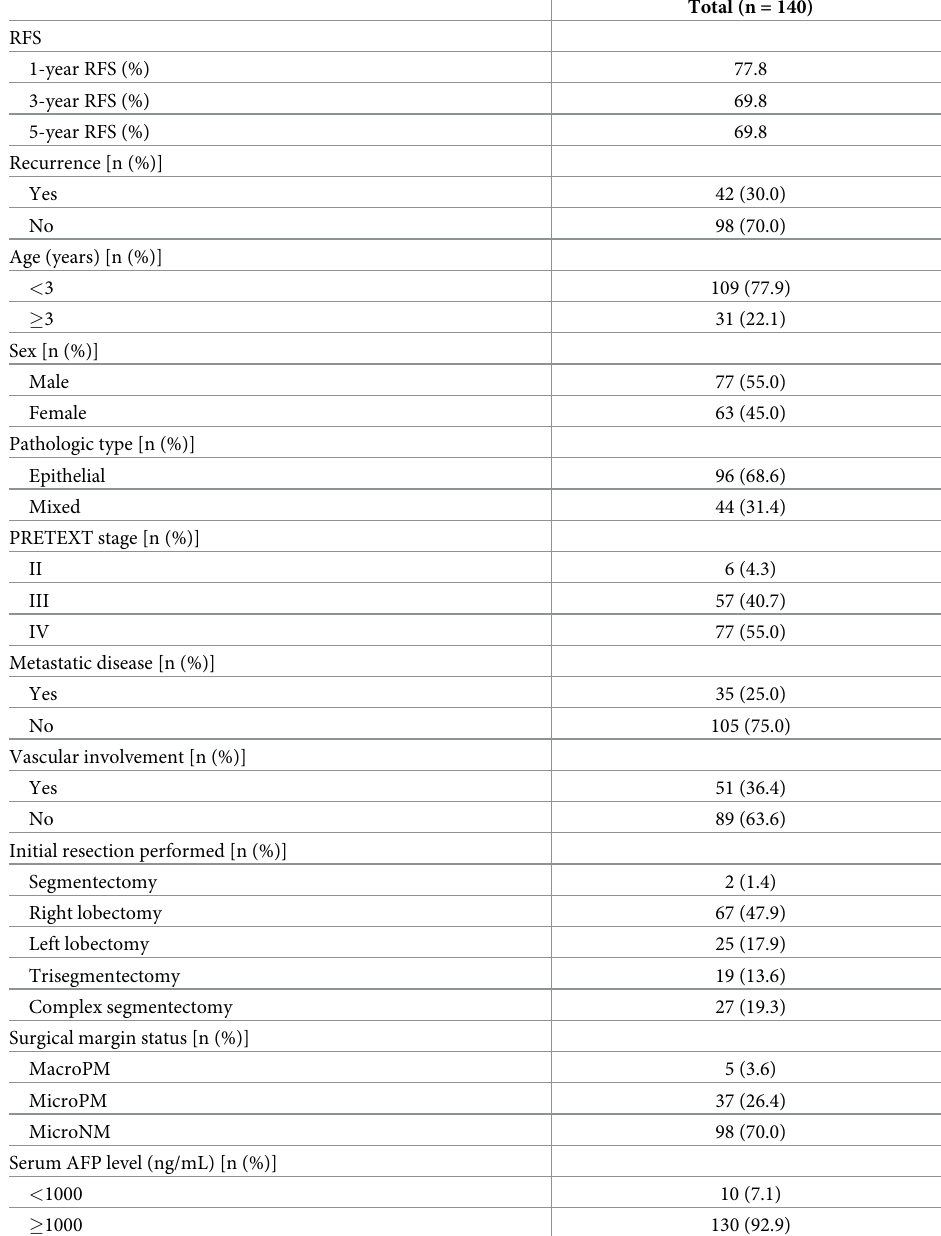
Table 2. Clinical features of 140 children with initial